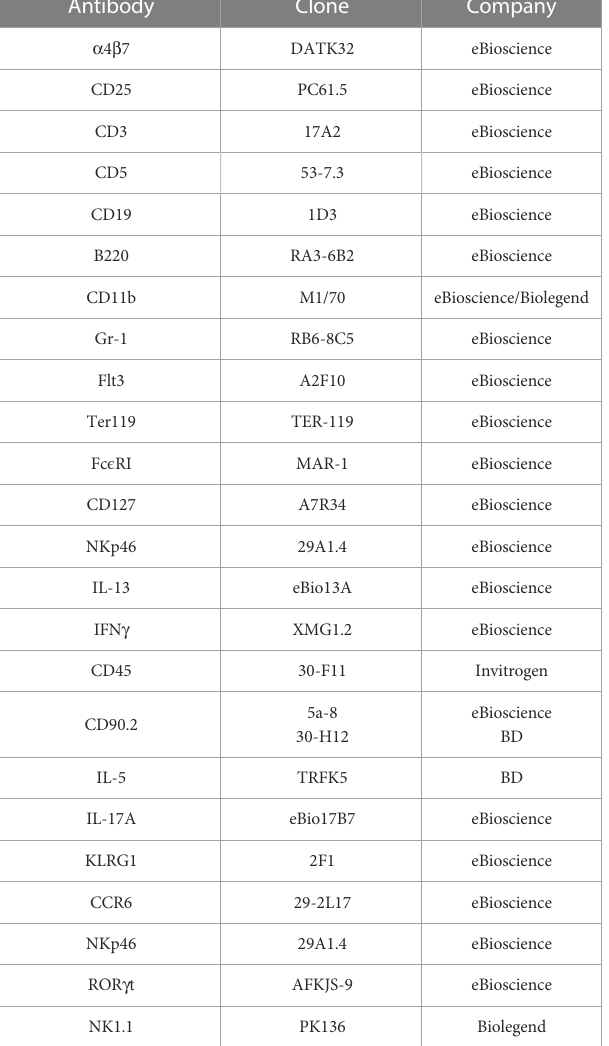
TABLE 1 Antibody clones and